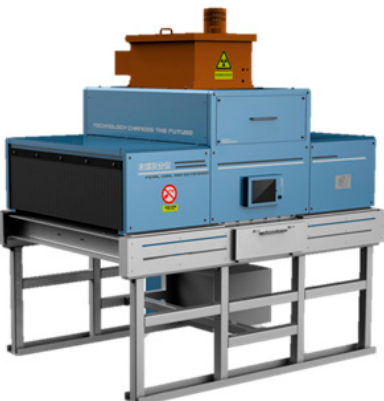
Minerals 2021 , 11 , x FOR PEER REVIEW